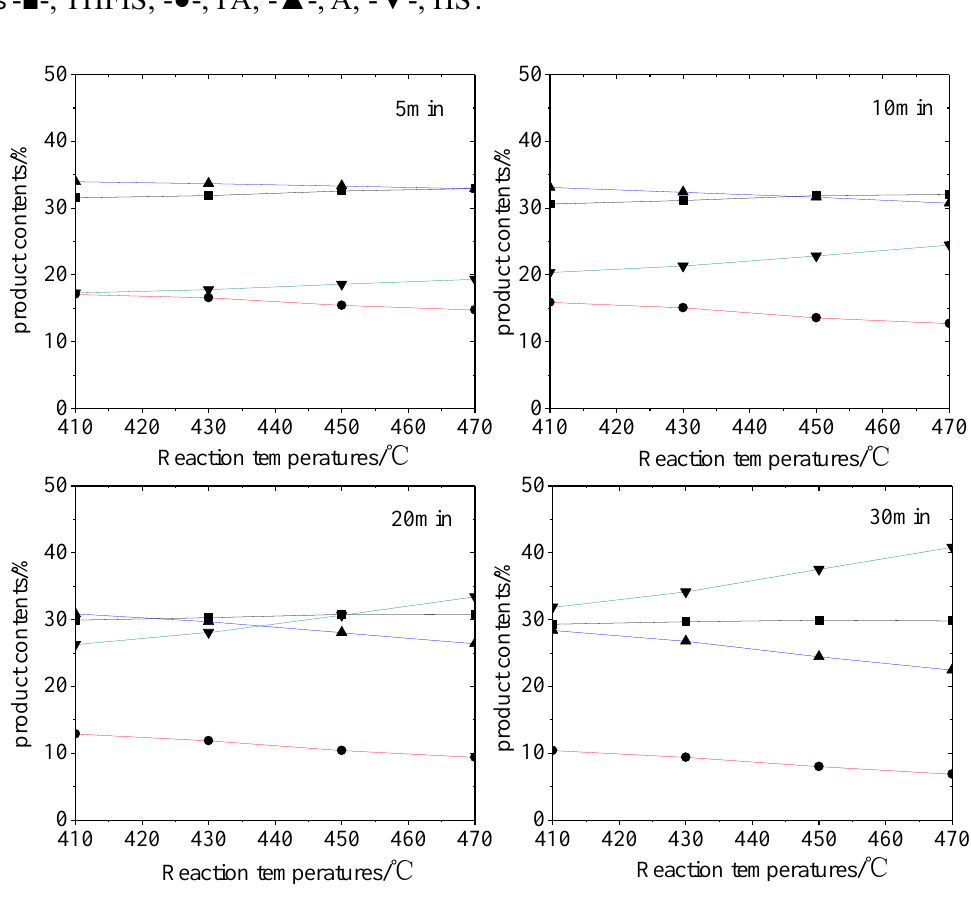
Figure 2. Product contents of Shenhua CHLR hydro-conversion vs. temperature at